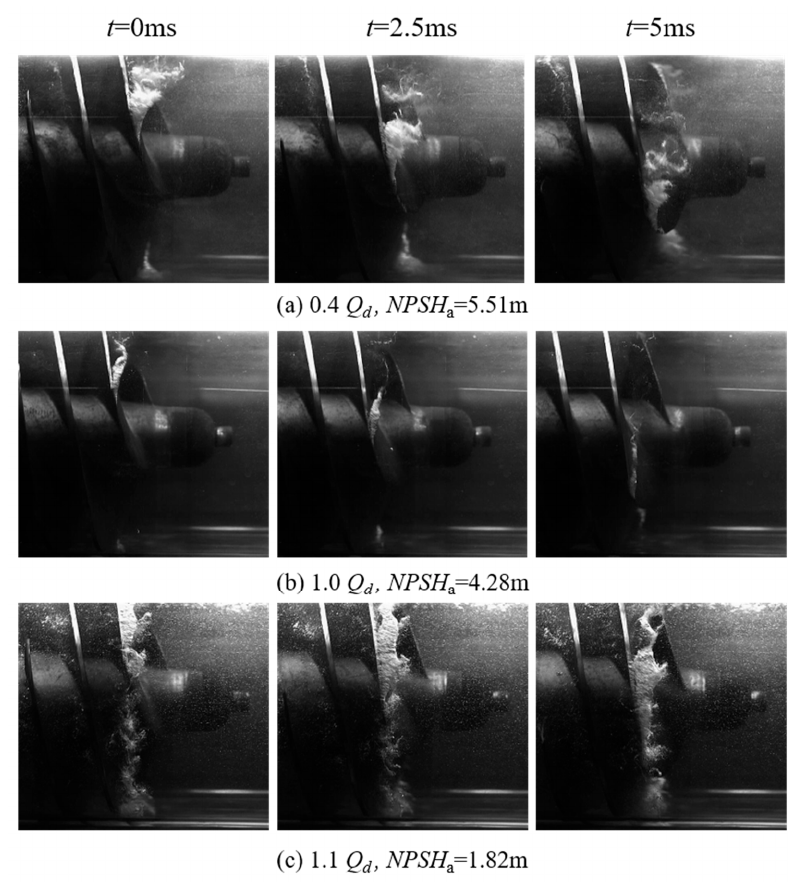
Figure 14. Evolution of cavitation under different conditions.